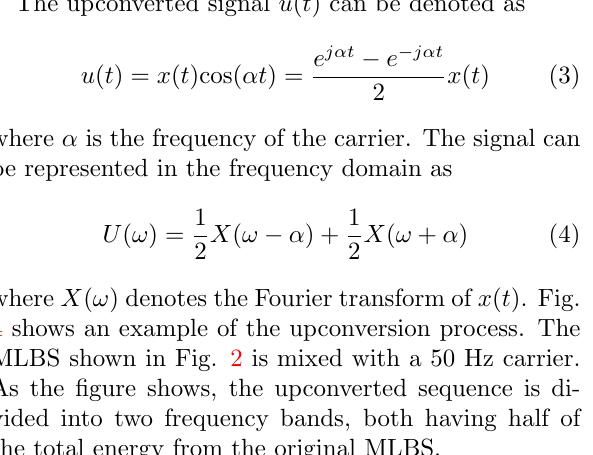
Figure 2: Power spectrum of 15-bit-length MLBS gen- erated at 10 kHz.